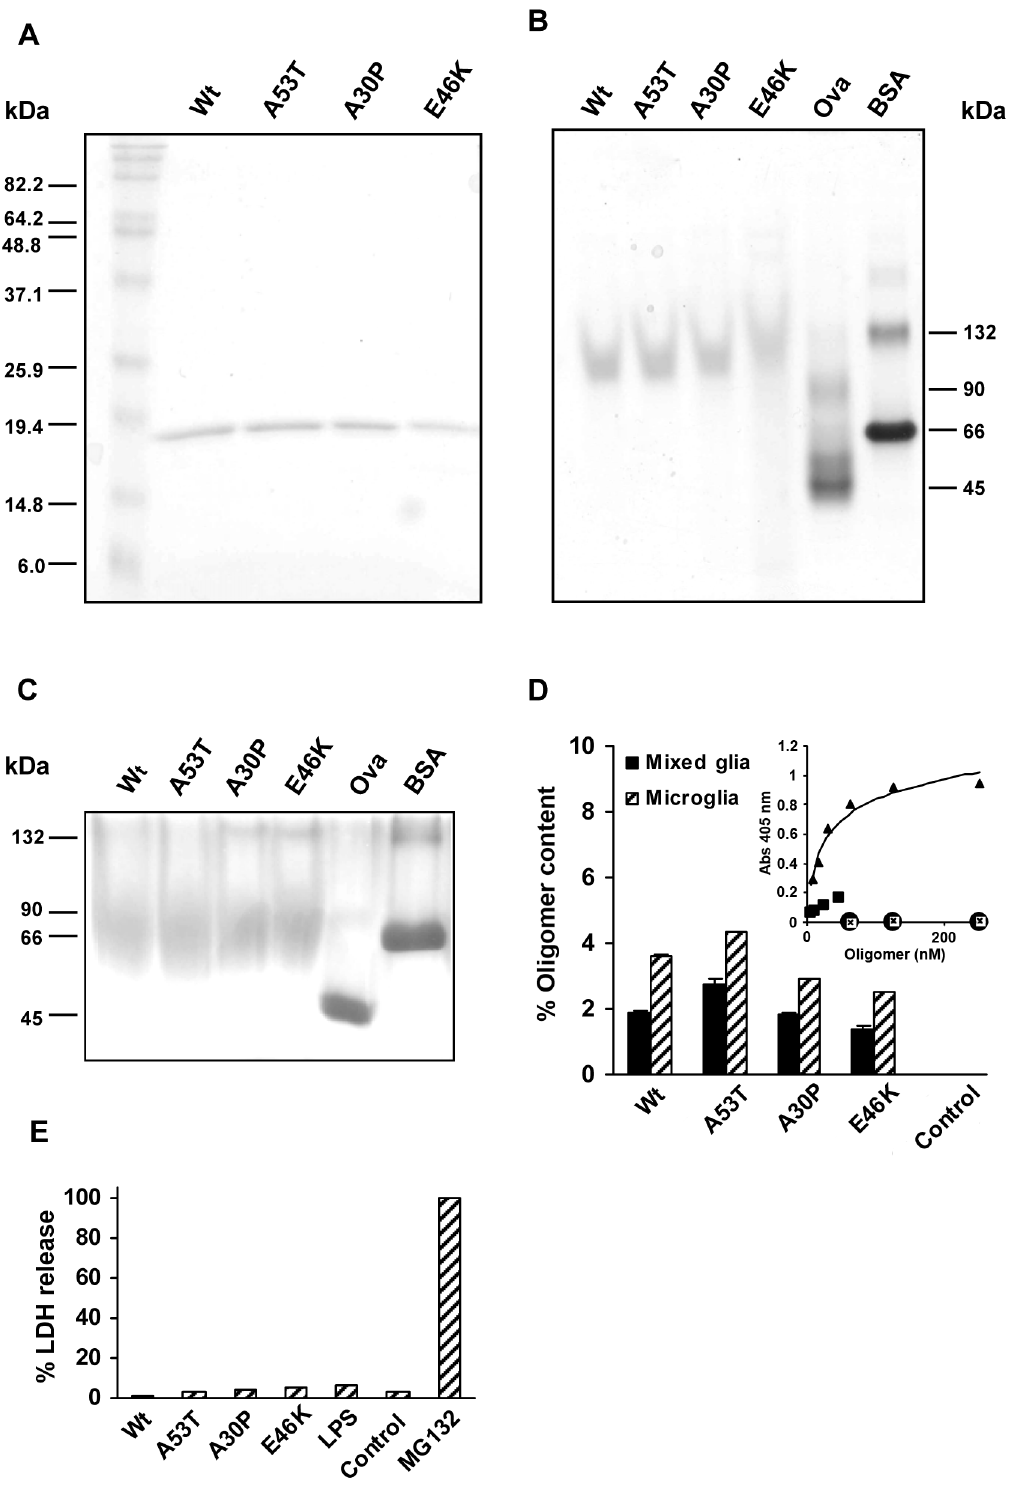
Figure 1. Determination of the purity, oligomeric state and cytotoxic effects of preparations of a -synucleins. ( A ) SDS-PAGE electrophoresis and ( B ) native PAGE electrophoresis of wild type (Wt) and mutant (A53T, A30P and E46K) a -Syn preparations; ( C ) BN-PAGE of wild type (Wt) and mutant (A53T, A30P and E46K) a -Syn preparations; ( D ) a -Syn oligomer content after 20 hr incubation with cells (on a protomer basis), relative to the initial amount of exogenously added a -Syn, as determined by sandwich ELISA. ( E ) LDH release in mixed glial cultures following incubation for 20 hours with the highest concentration of a -Syn used in our experiments, i.e. 5 m g/ml. MG132, a proteasome inhibitor, was used at 6 m M as a control. Values are means from triplicate measurements.